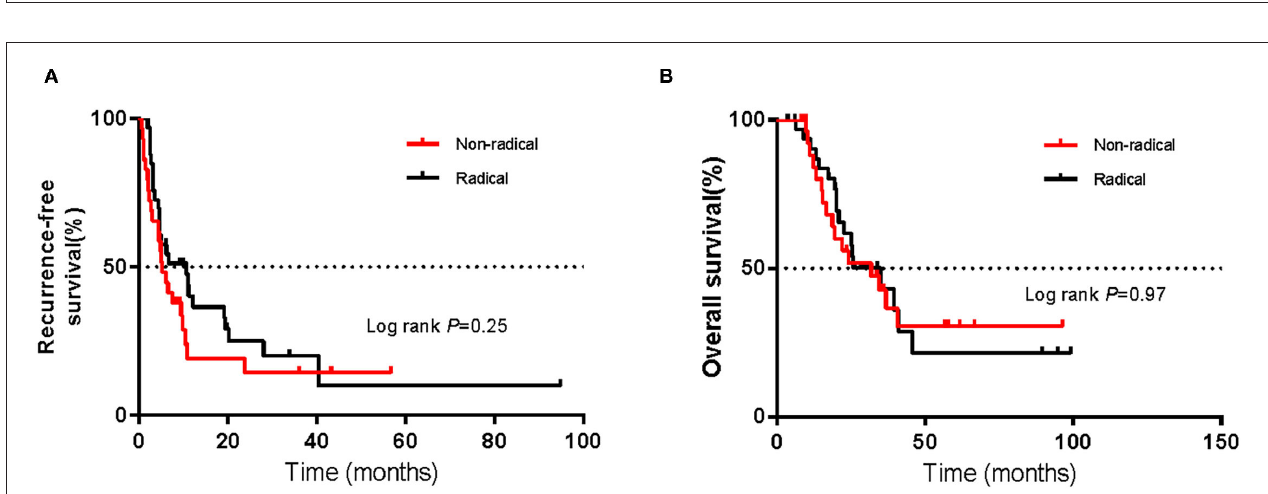
FIGURE 3 | Kaplan–Meier curves of (A) recurrence-free survival and (B) overall survival of patients with vaginal melanoma in the non-radical resection and radical resection groups. The log-rank test was used to evaluate differences between groups.